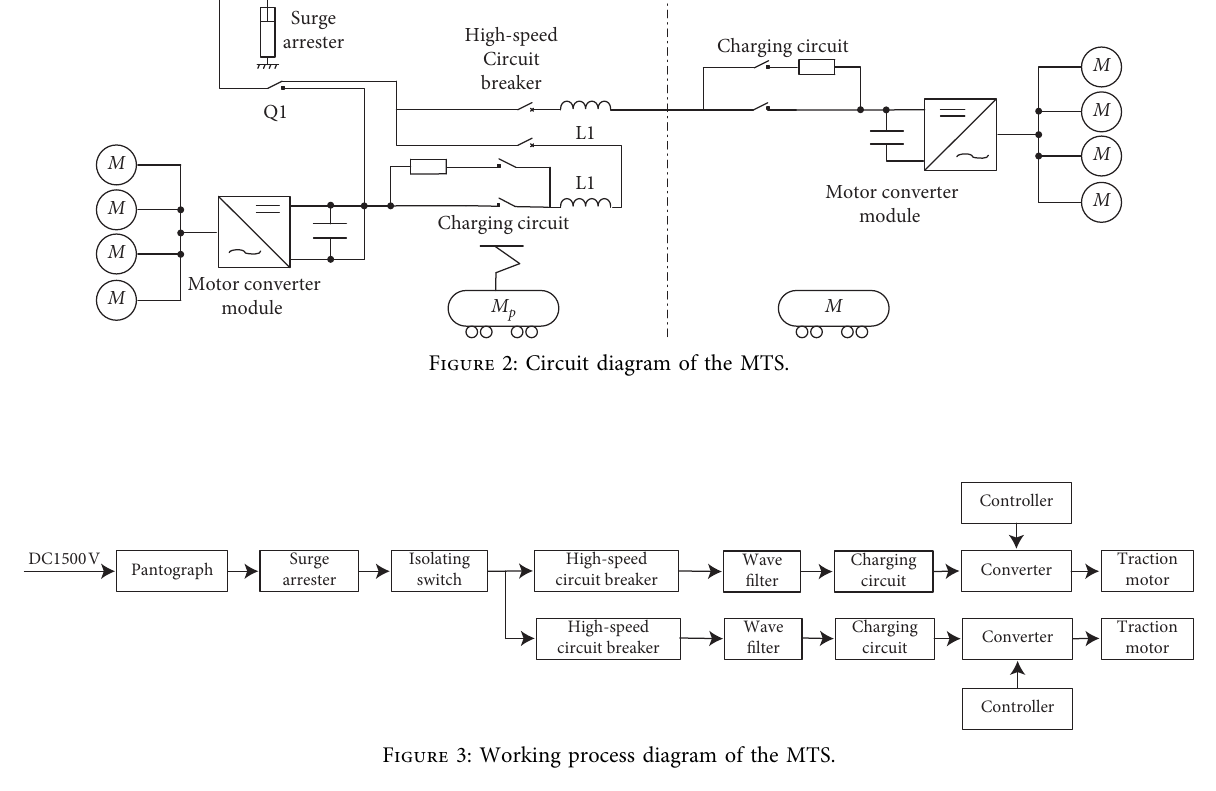
Figure 3: Working process diagram of the MTS.